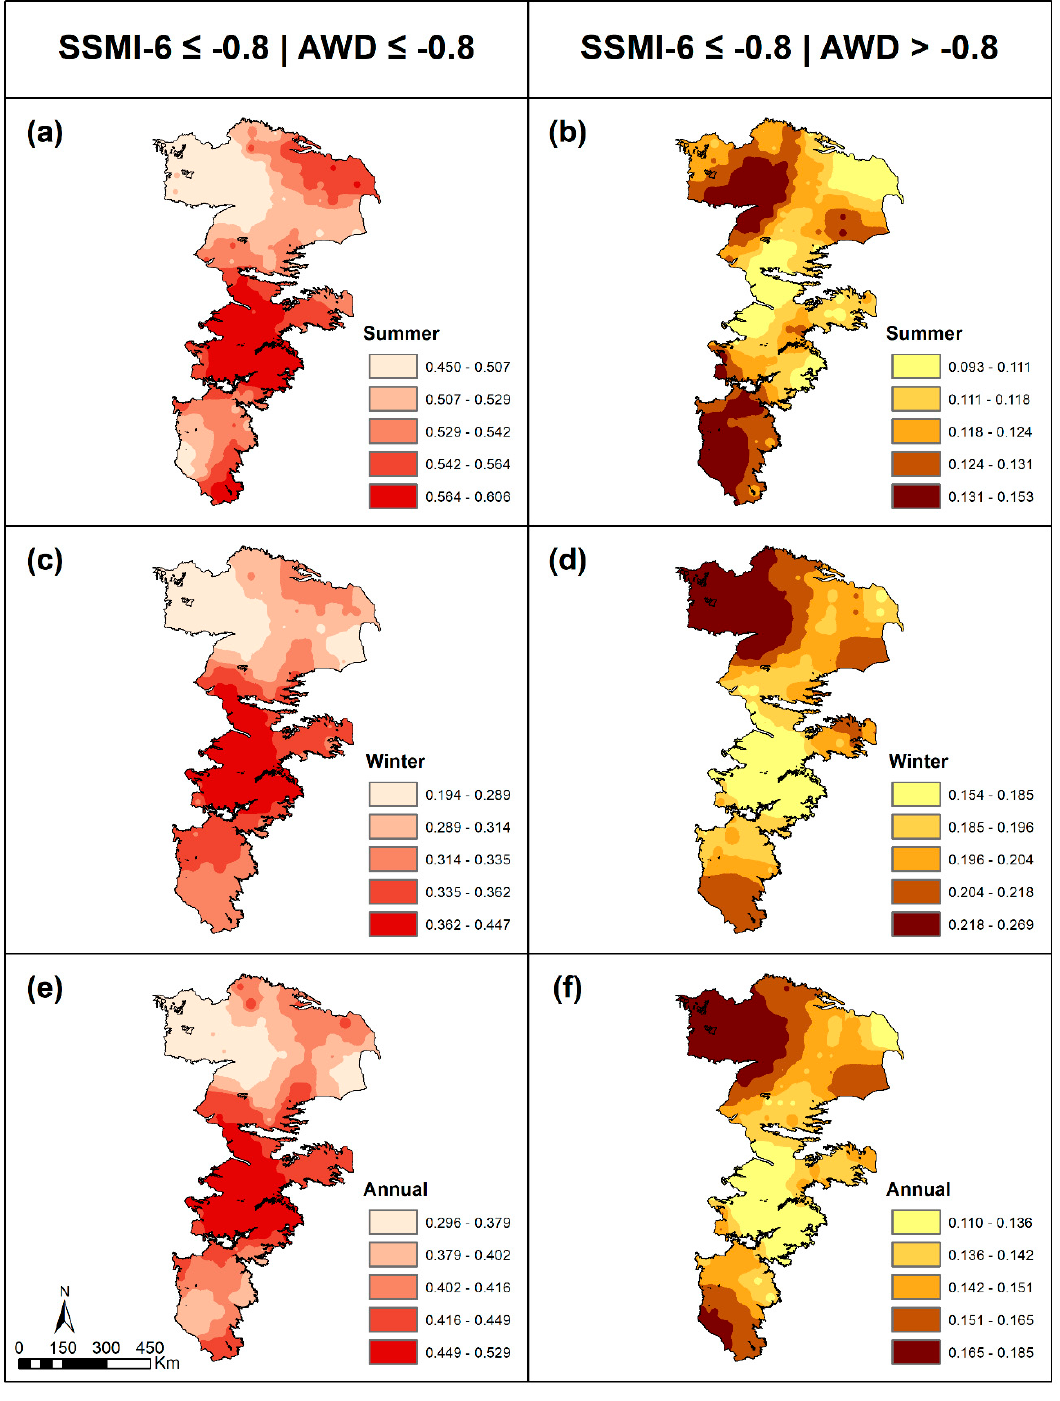
Figure 12. Agricultural drought risk based on SSMI6 given dry (AWD ≤ − 0.8) and not dry (AWD > − 0.8) atmospheric water states. (Dry states depicted in Figures ( a , c , e ) and not dry states in Figures ( b , d , f )).